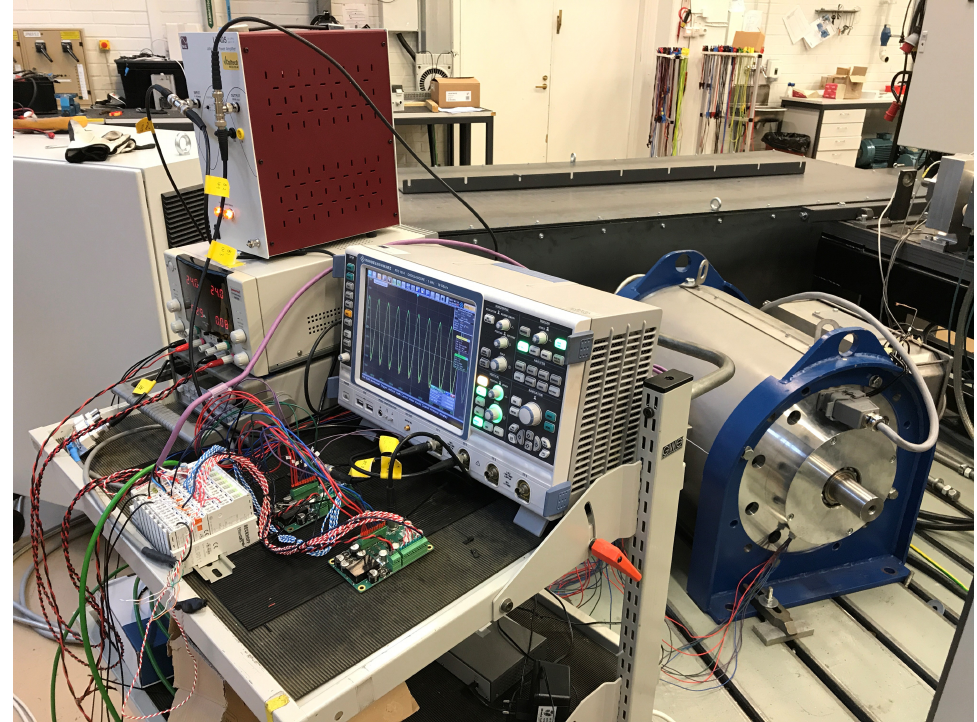
Figure 7. Measurement setup with a 350 kW, 15,000 r/min industrial high-speed induction machine and interface electronics for the displacement